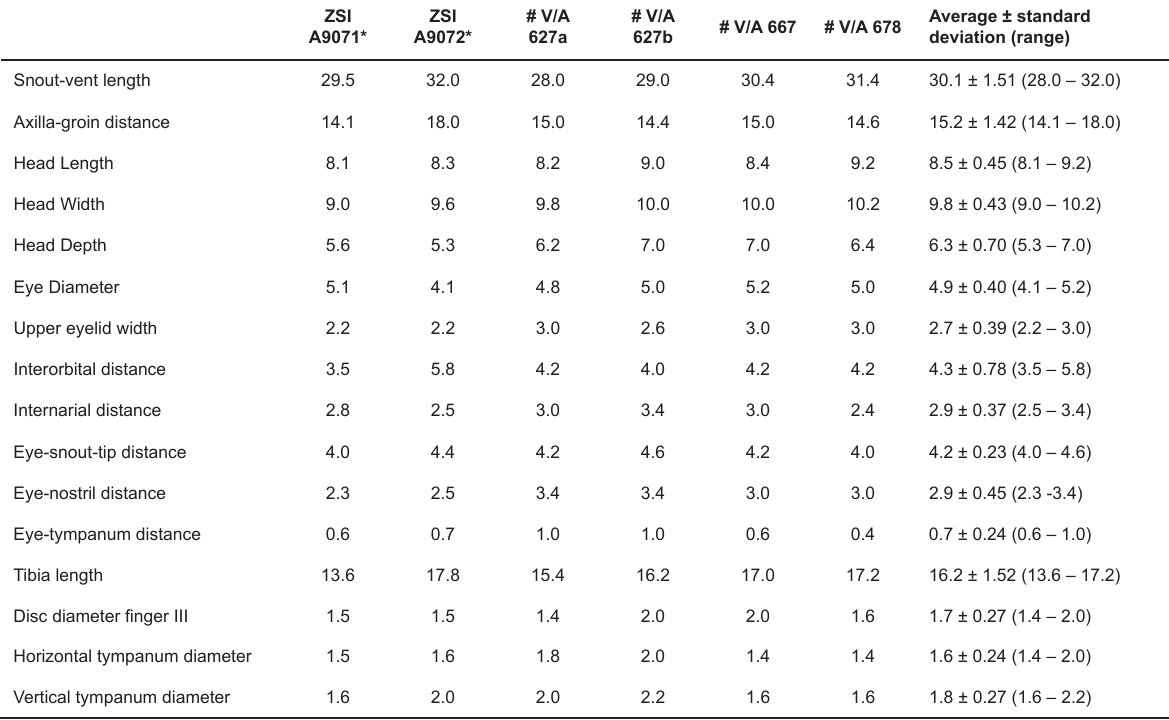
Table 1. Morphometric data of Rhacophorus lateralis .